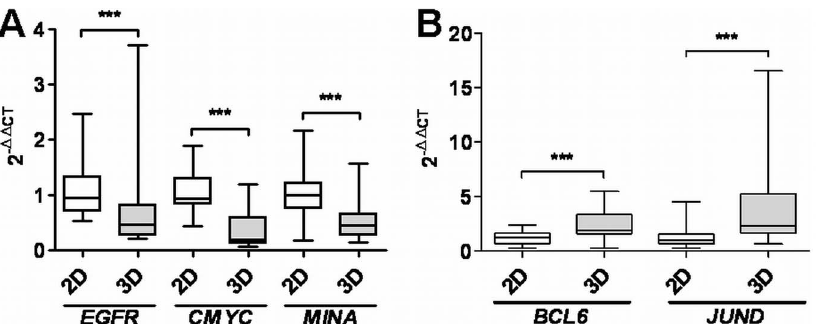
Figure 4. The 3D microenvironment impairs the regulation of genes involved in proliferation. Total RNA was isolated from cells cultivated in 2D and 3D microenvironments. Quantitative RT-PCR was performed and differences in gene expression levels were calculated using the 2 2 DD CT method. The mean fold change in expression of the target gene in 2D or 3D culture conditions was calculated using 2 2 DD CT , where DD CT=(CT Target – C GAPDH ) culture condition - (CT Target - C GAPDH ) 2D . 2 2 DD CT -values of all CRC cell lines (n=7) were pooled and are presented as a box plot. A) Indicates genes being downregulated in 3D microenvironments, whereas B) shows upregulated genes. Two-tailed P -values were calculated